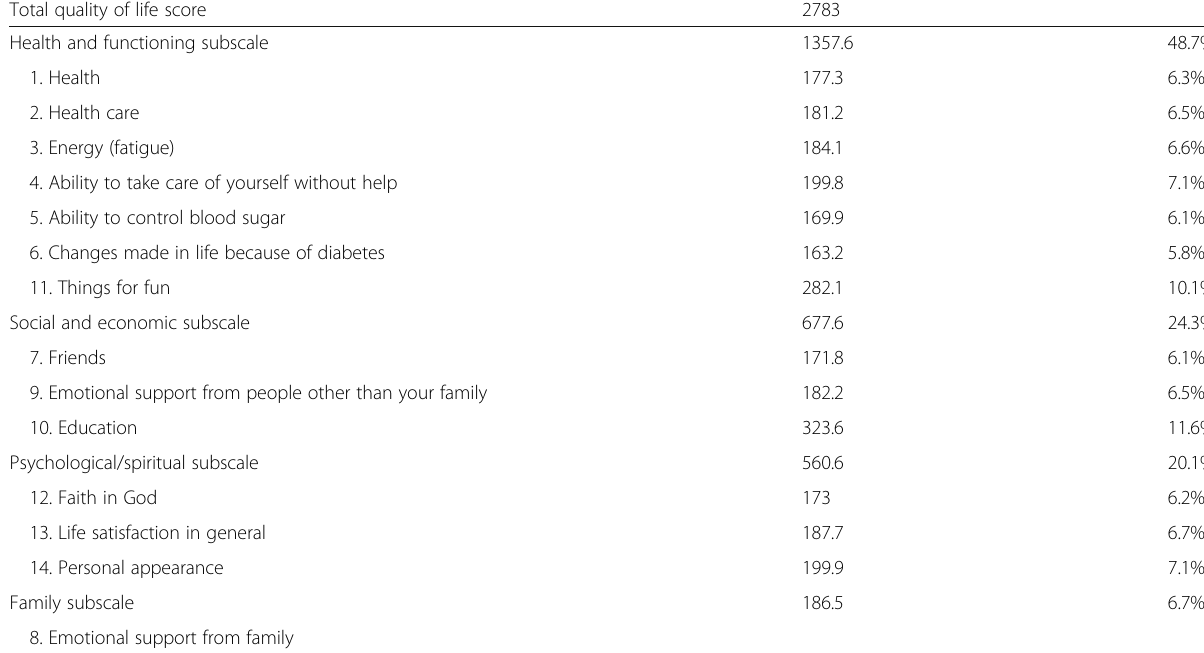
Table 7 Quality of life questionnaire score of adolescent patients aged from 10 to 16 years Total quality of life